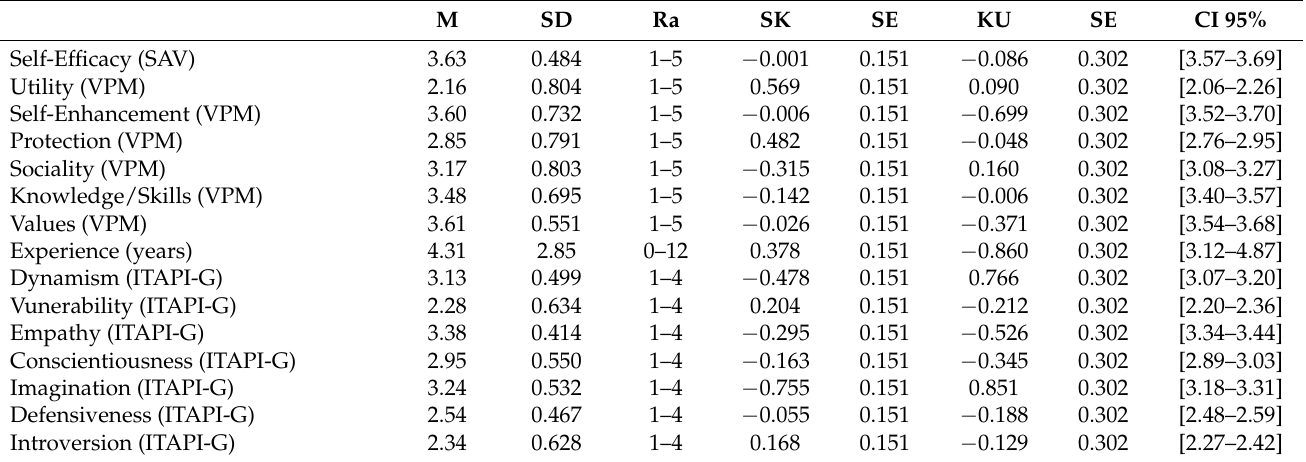
Table 2. Descriptive statistics for self-efficacy, motivations, work experience, and trait